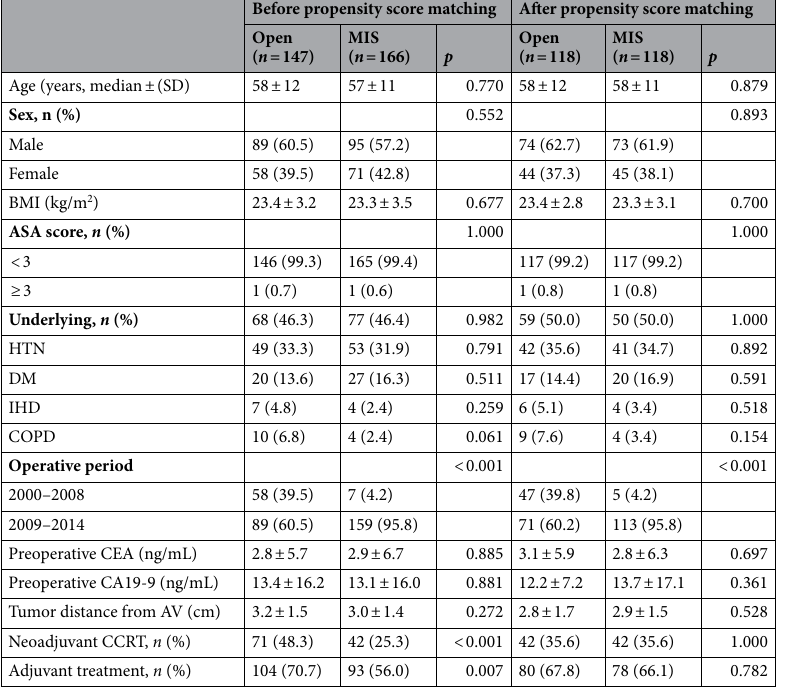
Table 1. Demographic characteristics of patients treated with and without nCRT. nCRT neoadjuvant chemoradiotherapy, MIS minimally invasive surgery, BMI body mass index, ASA American society of anesthesiologists, HTN hypertension, DM diabetes mellitus, IHD ischemic heart disease, COPD chronic obstructive pulmonary disease, CEA carcinoembryonic antigen, AV anal